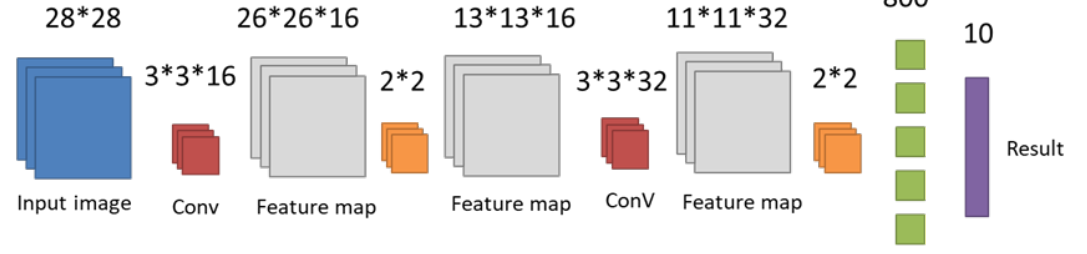
Figure 16. LeNet-5 NN